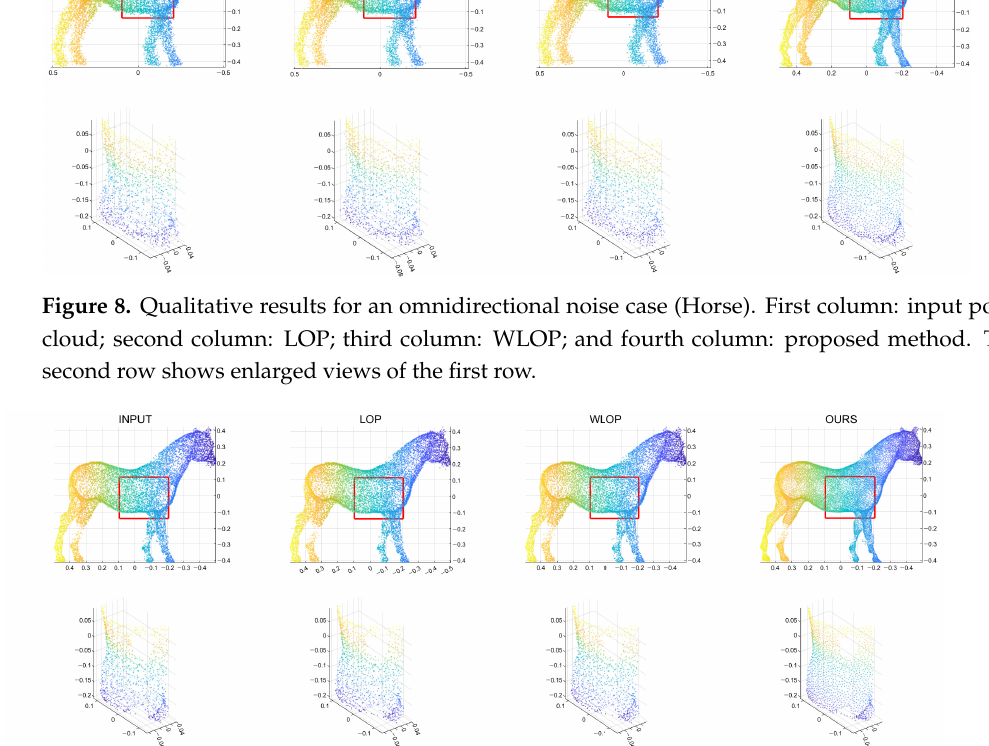
Figure 9. Hole-filling results for the tangential directional noise case (Horse). First column: input point cloud with holes and tangential noise; second column: LOP; third column: WLOP; and fourth column: proposed method. The second row shows enlarged views of the first